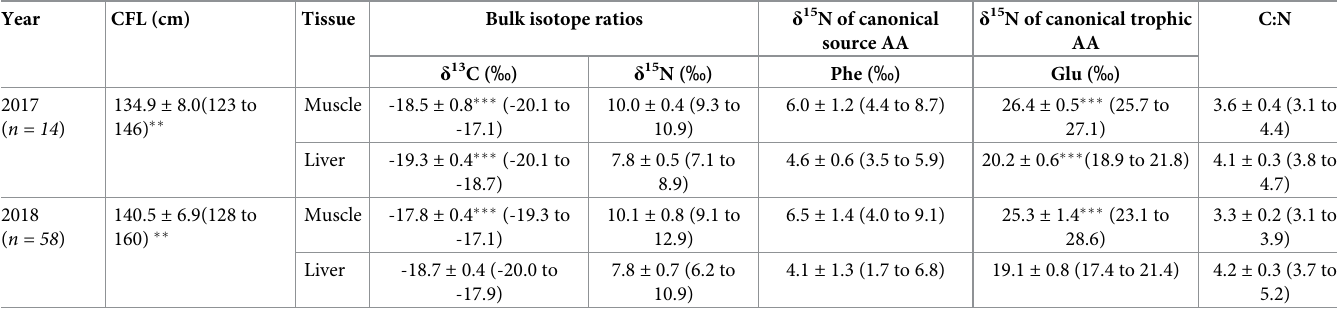
Table 1. Isotopic composition of soft tissues of YFT caught in the central and southern GM.